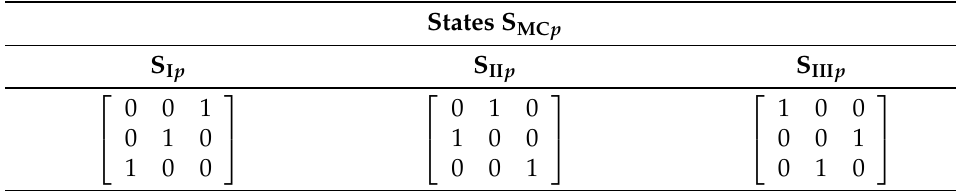
Table 3. Allowed S MC p switch states.